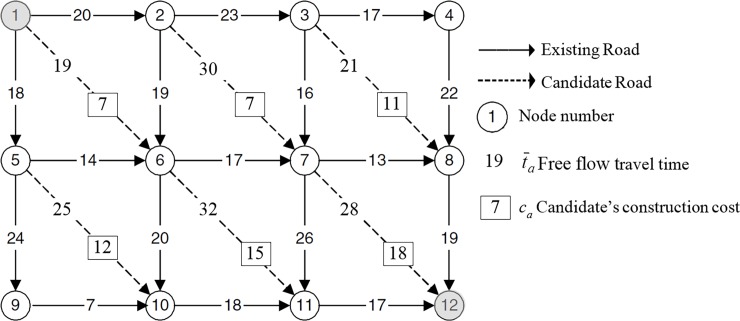
Gao’s test network.